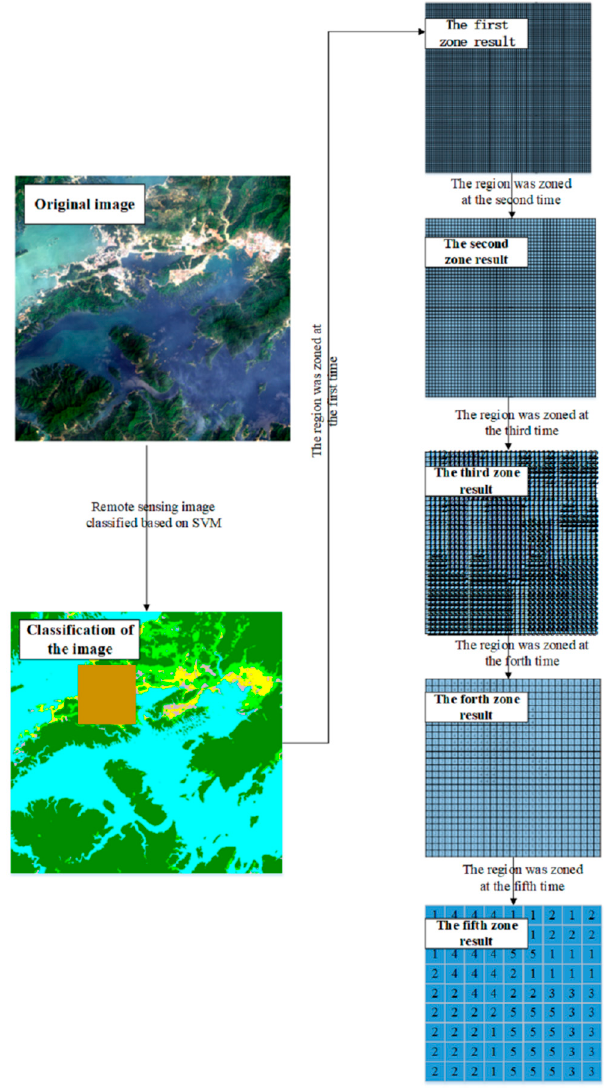
Figure 2. Step-by-step zoning of remote sensing images based on the fragmentation index.